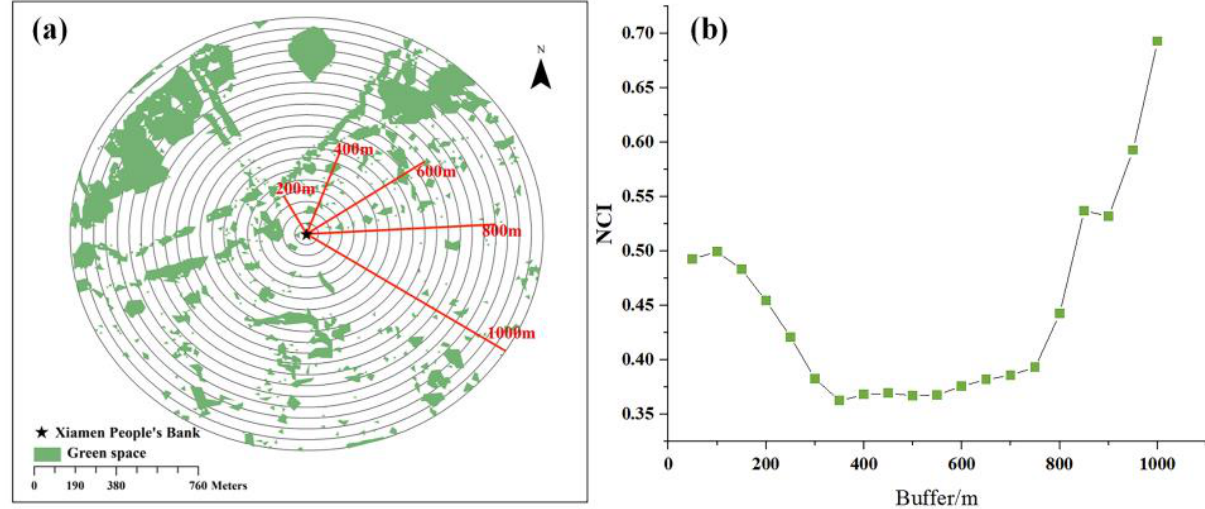
Figure 2. Schematic of the green space compactness for different buffer zones. ( a ) Xiamen People’s Bank of China is taken as an example. The green space within 1 km of the People’s Bank of Xiamen is divided into 20 buffer zones; ( b ) The value of green space compactness of 20 buffer zones. (Note: NCI is the value of green space compactness).